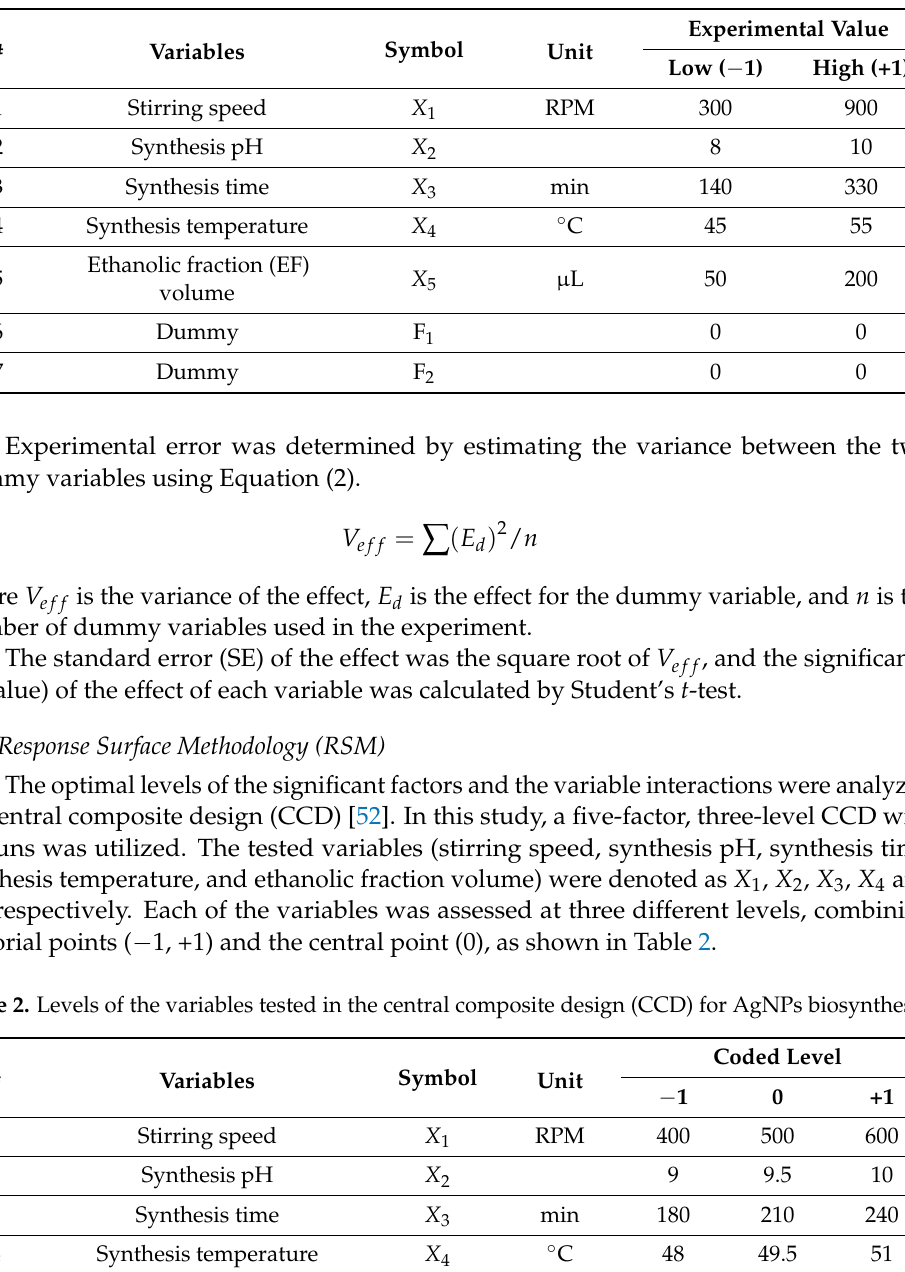
Table 1. Levels of the variables tested in the Plackett-Burman design for AgNPs biosynthesis.